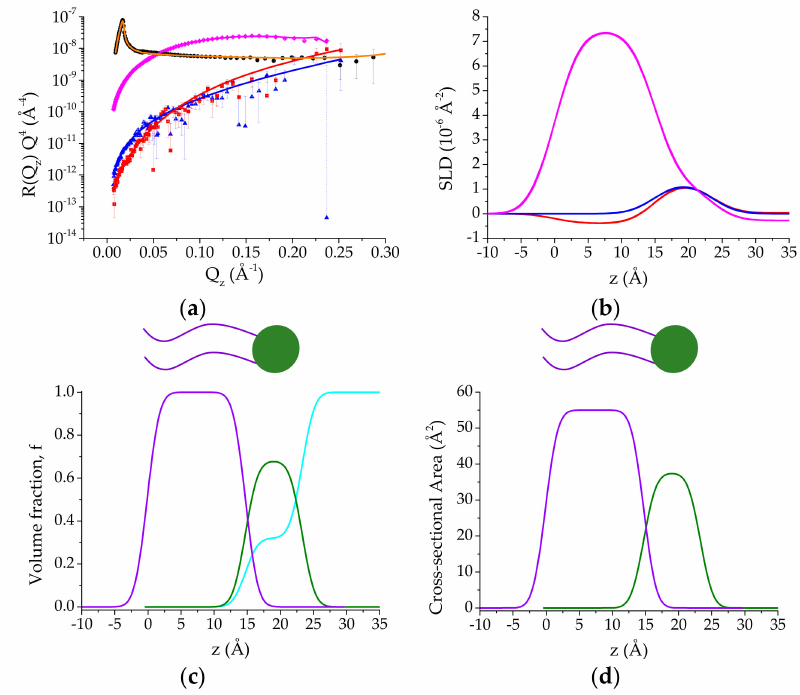
Figure 3. ( a ) Neutron reflectivity data of pure D 2 O interface (black circle), h-DPPC (red squares), cm-DPPC (blue triangles), and d62-DPPC (magenta diamonds) monolayers at Π = 30 mN · m − 1 in HKM-ACMW. The fitting curves of the bare D 2 O interface (orange curve), h-DPPC (red), cm-DPPC (blue), and d62-DPPC (magenta) monolayers are shown. The χ 2 value is 2. The figure is displayed on an R (Q z )Q z4 scale to highlight the quality of the fits at high Q z values. ( b ) SLD profiles normal to the interface of monolayers of h-DPPC (red), cm-DPPC (blue), and d62-DPPC (magenta) monolayers at Π = 30 mN · m − 1 . ( c ) Volume fraction profiles normal to the interface of monolayers to highlight the distribution of tails (violet) and heads (green). ( d ) Cross-sectional area profiles normal to the interface of monolayers to highlight the distribution of tails (violet) and heads (green). Note that the area of the head-groups here does not consider the